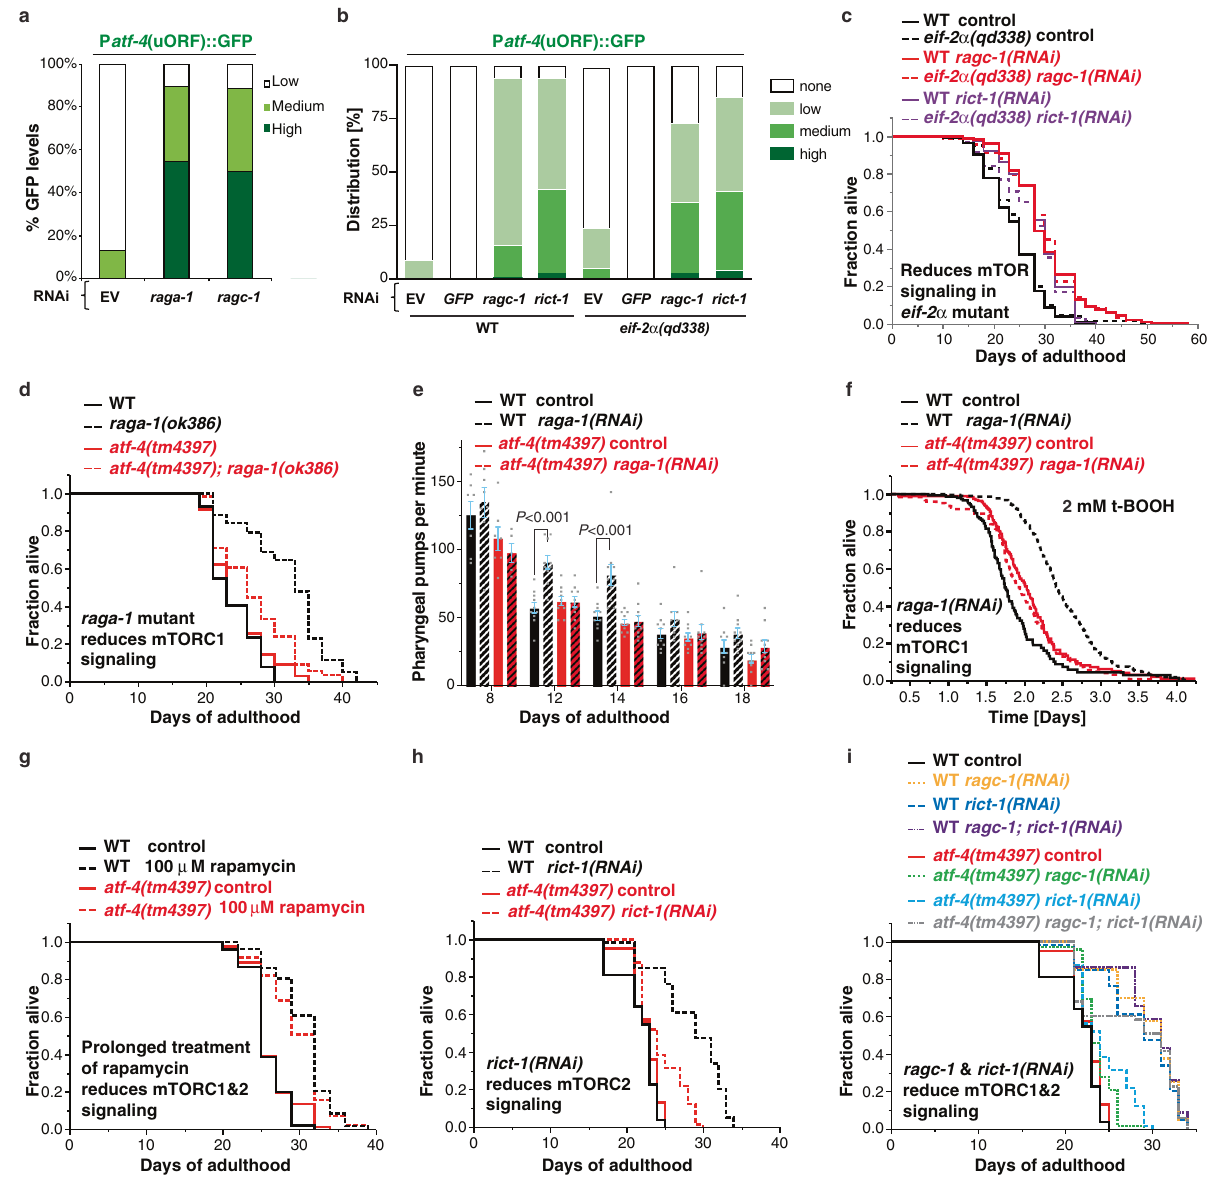
Fig. 6 ATF-4 is essential for longevity from reduced mTORC1 activity. a Inhibition of mTORC1 by either raga-1 or ragc-1 knockdown led to preferential translation of ATF-4. RNAi treatments were initiated at the L4 stage, with GFP intensity scored at day 3 of adulthood. b Inhibition of mTORC1 or mTORC2 by knockdown of ragc-1 or rict-1 , respectively, leads to preferential translation of ATF-4. Similar effects were observed in WT and eif-2 α (qd338) mutants. c Post- development knockdown of raga-1 or rict-1 extends lifespan in both WT and eif-2 α (qd338) mutants. d Mutation in raga-1 increases lifespan in an atf-4 -dependent manner. e Reducing mTORC1 signalling by adulthood speci fi c raga-1 knockdown improves healthspan dependent upon atf-4 , as assessed by pharyngeal pumping rate. Mean±S.E.M. P values relative to WT of the corresponding day with One-way ANOVA with post hoc Dunnett ’ s multiple comparisons test. f Adult-speci fi c knockdown raga-1 increases oxidative stress resistance (2mM tert-butyl hydrogen peroxide (tBOOH)) in an atf-4 -dependent manner. RNAi was started at the L4 stage, and stress resistance was measured at day 3 of adulthood with the lifespan machine (See Supplementary Data 10 for details). g Rapamycin treatment during adulthood extends lifespan independently of atf-4 . h Adult-speci fi c knockdown of the mTORC2 subunit rict-1 extends lifespan in an atf-4 -dependent manner. i Adult-speci fi c inactivation of both mTORC1 and mTORC2 increases lifespan independently of atf-4 . For statistical details and additional trials in ( a ), ( b ), see Supplementary Data 9. For statistical details and additional lifespan trials in ( c ), ( d ), ( g )-( i ), see Supplementary Data